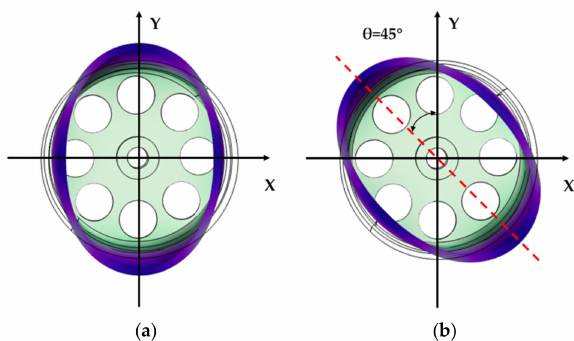
Figure 2. The n = 2 vibration mode of the cylindrical resonator analyzed by COMSOL Multiphysics 5.3a : ( a ) The primary mode; and, ( b ) The secondary mode.